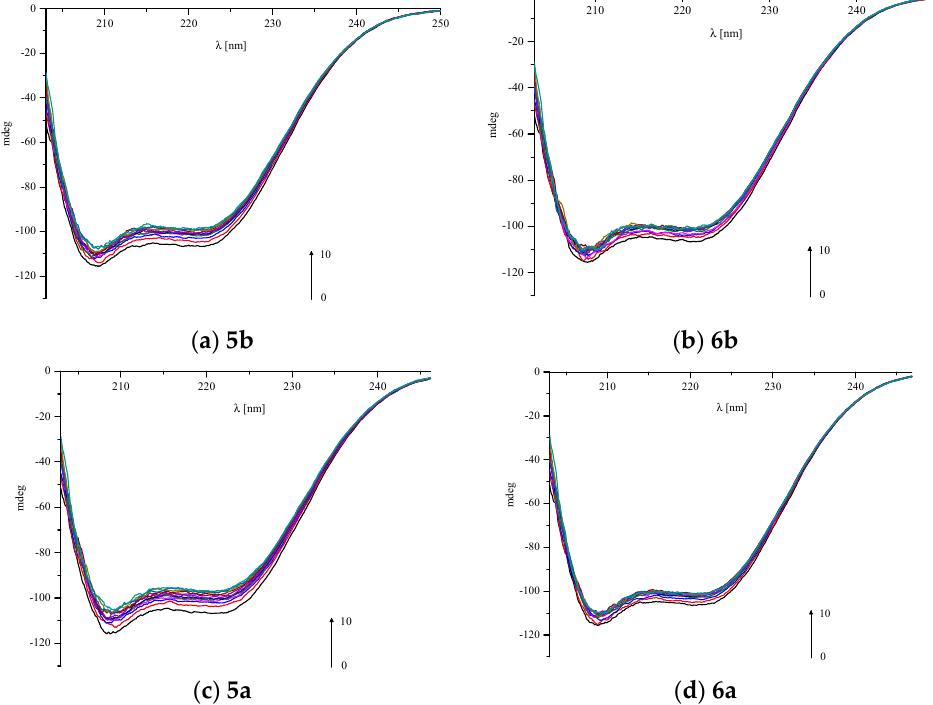
Figure 9. CD spectra of BSA in the absence and presence of all analyzed compounds. BSA to analyzed compounds molar ratios was changing from 1:0 to 1:10.